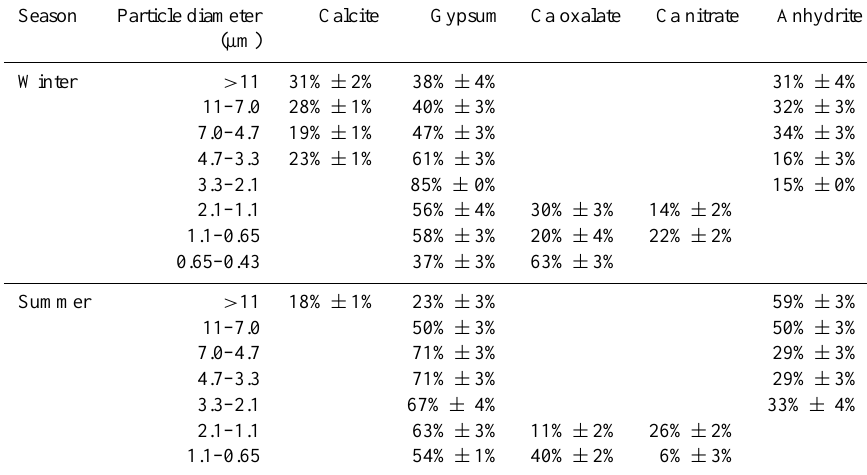
Table 2. Fraction of various Ca species at Tsukuba in winter and summer determined by XANES fitting (mol%). Season Particle diameter Calcite Gypsum Ca oxalate Ca nitrate Anhydrite (µm) Winter >